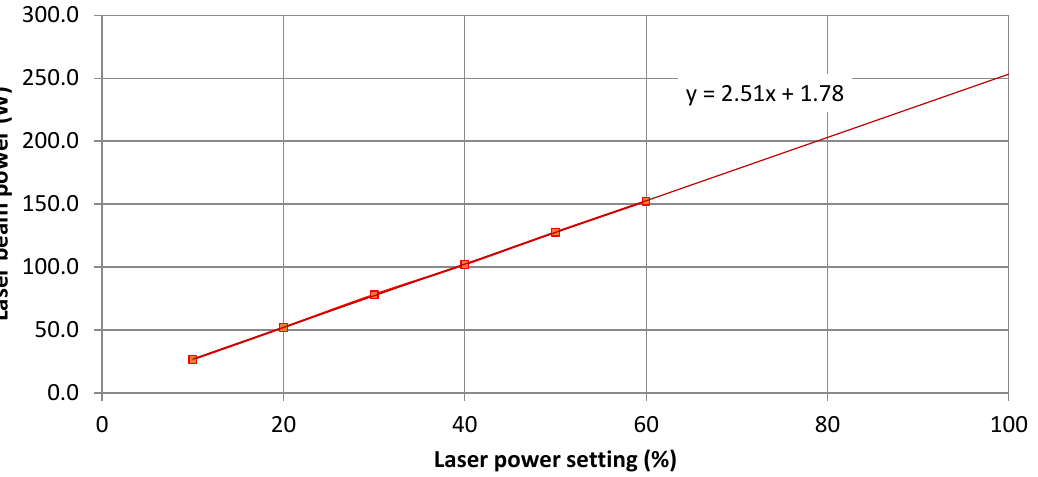
Figure 2. Correlation of laser power setting vs. beam power.